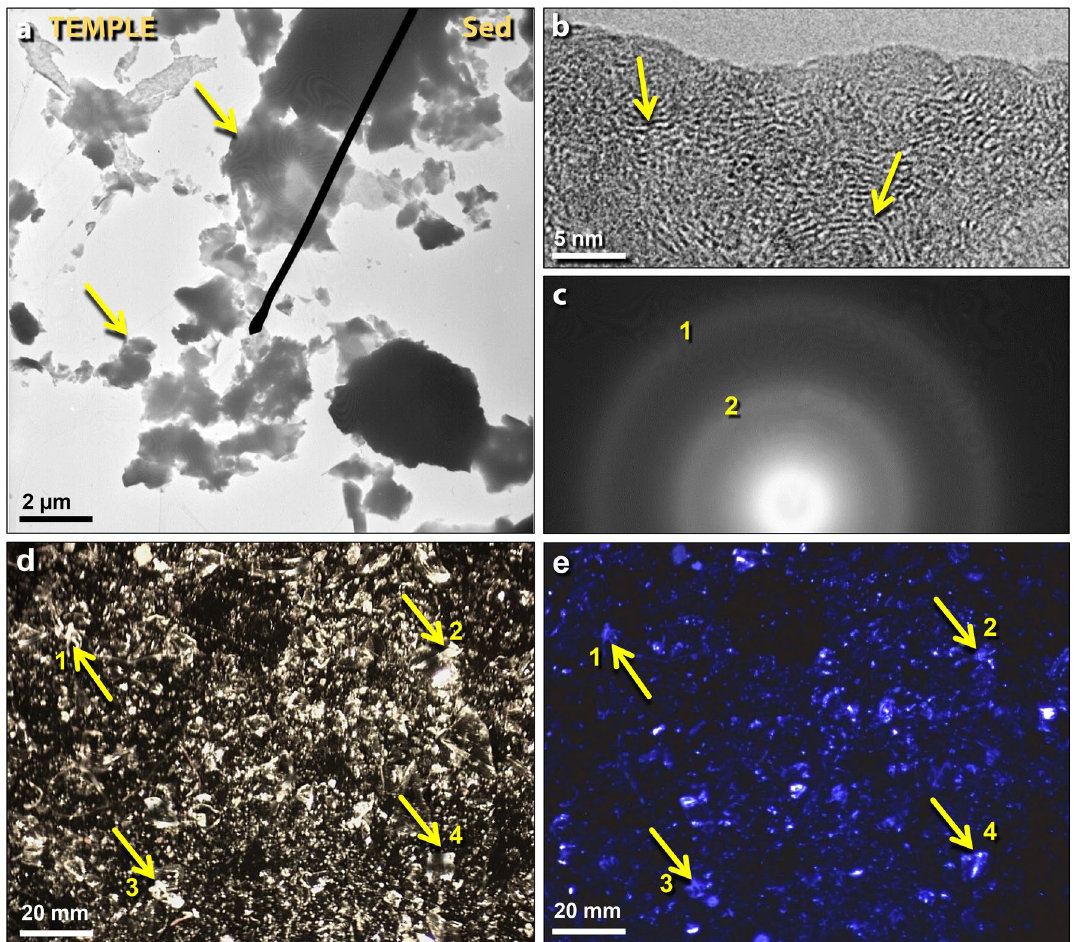
Figure 8. Diamonoids (diamond-like carbon) in temple sediment. ( a ) Transmission electron microscopy (TEM) image of clusters of amorphous diamonoids. ( b ) Bright-field high-resolution transmission electron microscopy (HRTEM) of acid-resistant residue showing the short-range ordering of carbon atoms. ( c ) Selected-area electron diffraction (SAD) of residue and grid film, confirming that the residue is amorphous carbon. ( d ) Photomicrograph of diamonoids showing white to clear material on black carbon SEM tab; ( e ) photomicrograph of the same area as in panel ‘ d ’ showing that the diamonoids luminesce at ~ 440 nm, typical of cubic